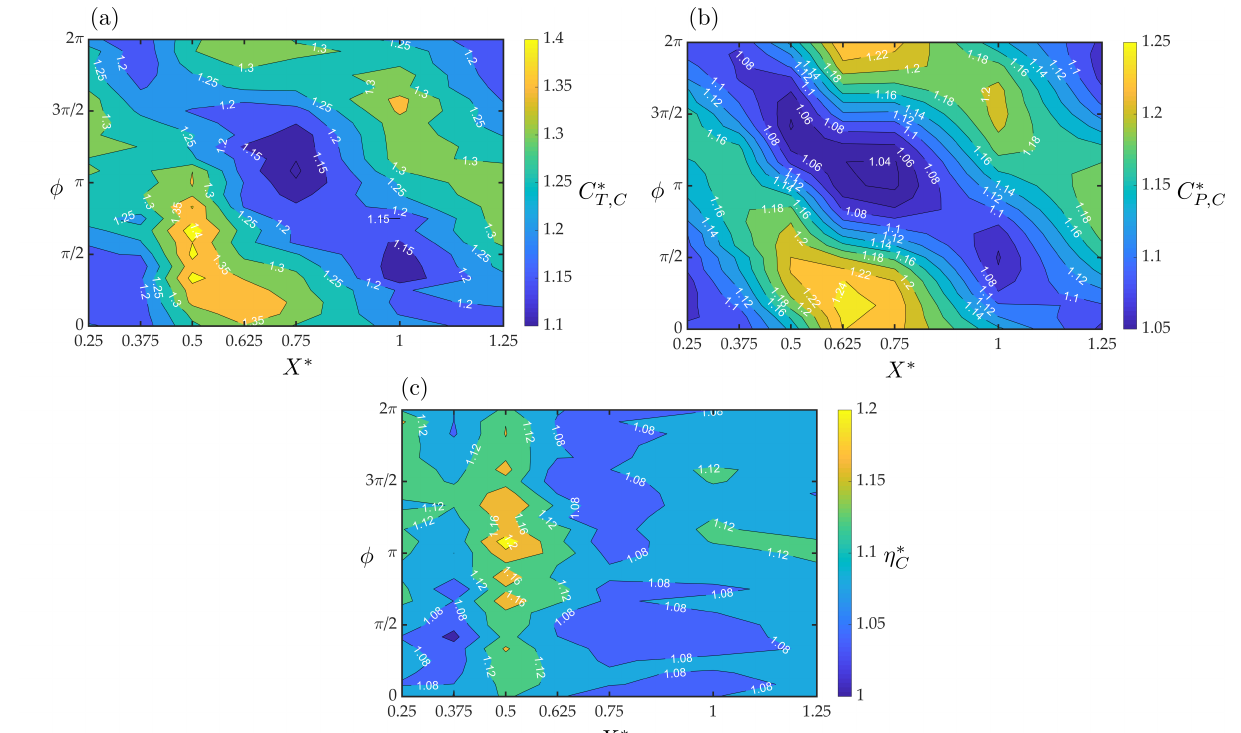
Figure 4. Normalized collective ( a ) thrust, ( b ) power, and ( c ) efficiency as a function of synchrony and streamwise spacing between the leader and follower